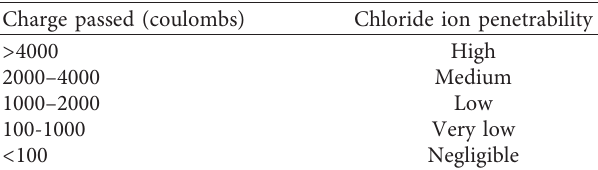
Figure 6: Recorded Q at 6 h. (a) S 54/20 and (b) S 54/60. Table 2: Results interpretation in compliance with [26].